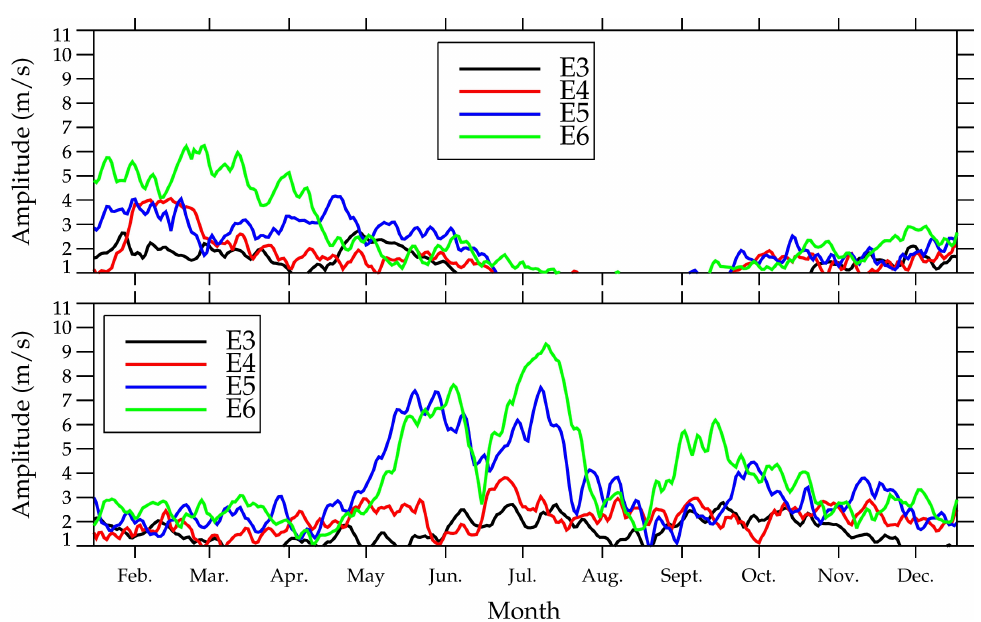
Figure 8. Meridional wind amplitudes of the 10-day eastward-propagating modes with zonal wavenumber 3 to 6 at ∼ 11 km deduced from the MERRA-2 data at 32 ◦ N ( top row ) and 32 ◦ S ( bottom row ) in